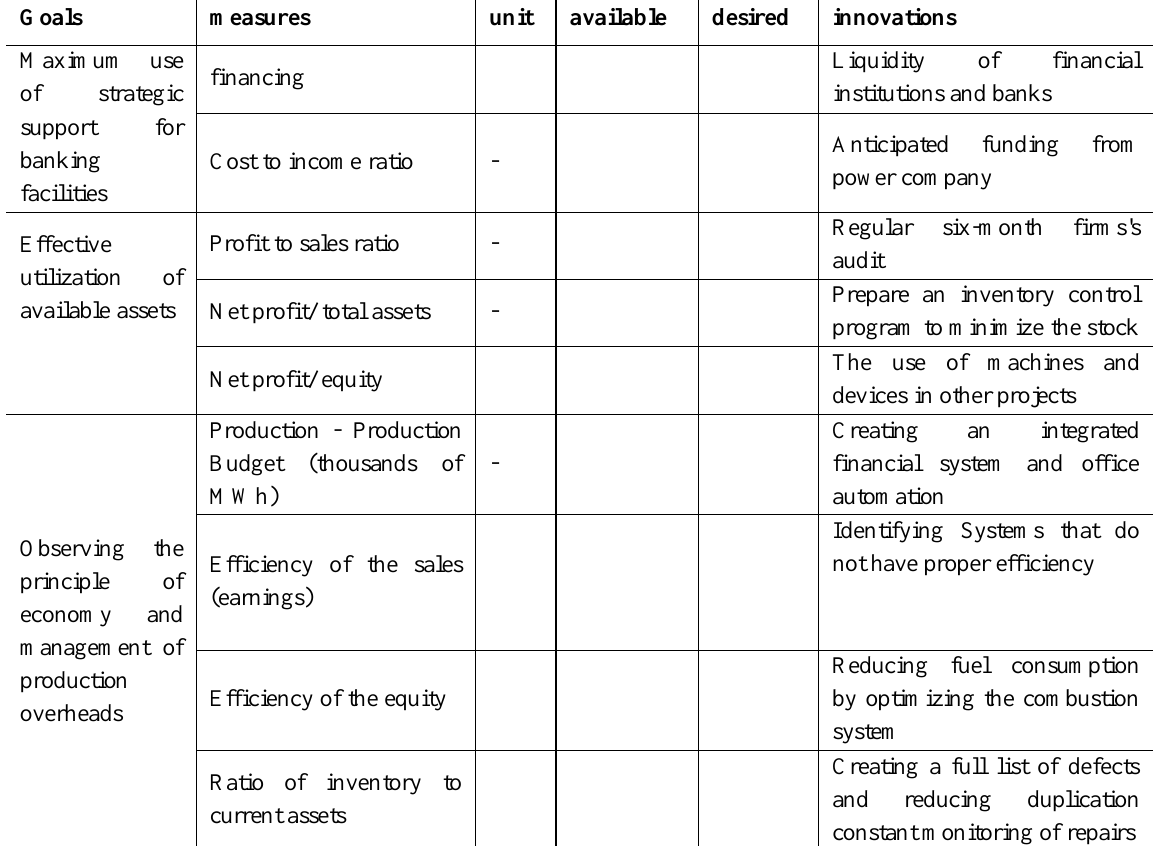
Table 1. Evaluated BSC from a financial perspective Strategic financial perspective (for financial success, income growth over financing sources should be